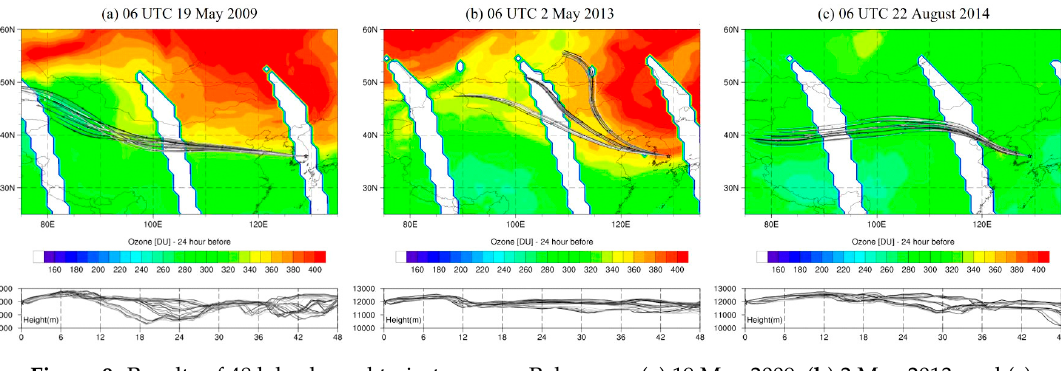
Figure 9. Results of 48 h backward trajectory over Pohang on ( a ) 19 May 2009, ( b ) 2 May 2013, and ( c ) 22 August 2014, respectively. The background contour represents the total column ozone of the day before each case obtained from the Ozone Monitoring Instrument (OMI) / Aura satellite data (Level 3).